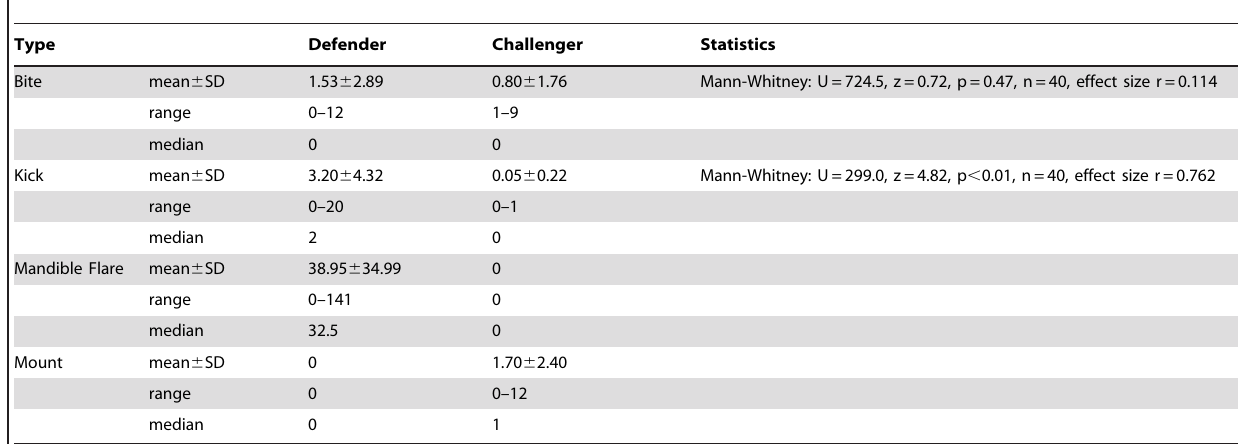
Table 1. The four most common male fighting behaviours are performed at different rates by defenders compared with challengers (n=40